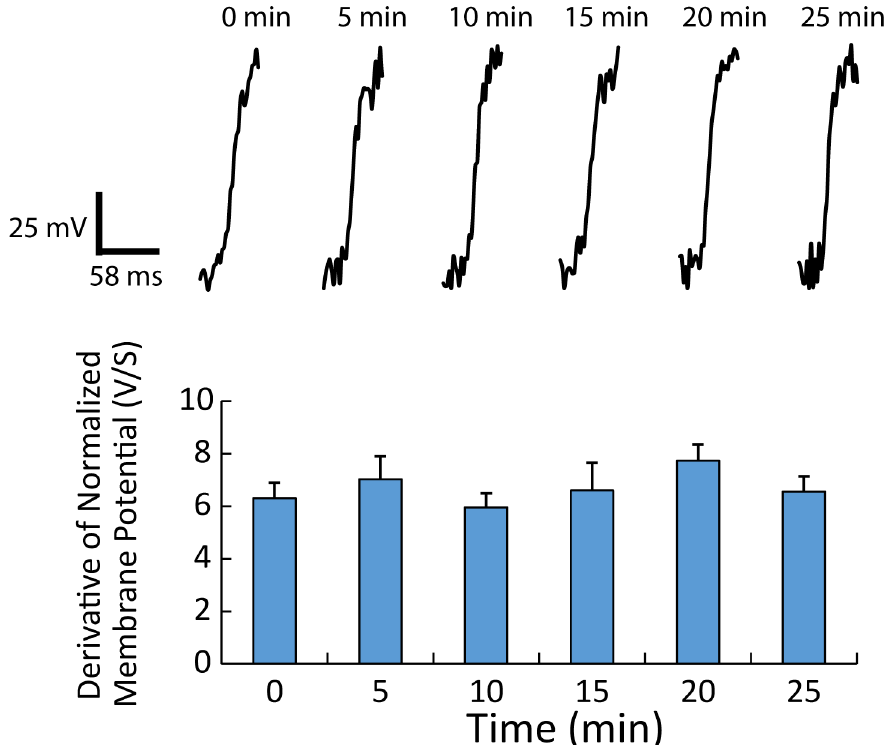
Fig 6. Effect of optical pacing on action potential upstroke. Top shows action potential upstrokes normalized to a 100 mV action potential that were recordedwithin 0.5 mm of the stimulationsite, before pacingbegan (baseline,0 min) and then after continuous pacing at 5 min, 10 min, 15min, 20 min, and 25 min. Bottom shows maximum dVm/dt duringthe upstroke for sites within 0.5 mm of the stimulationsite (n = 4). No significantdifferences were observed betweenbaseline(0 min) and all other time